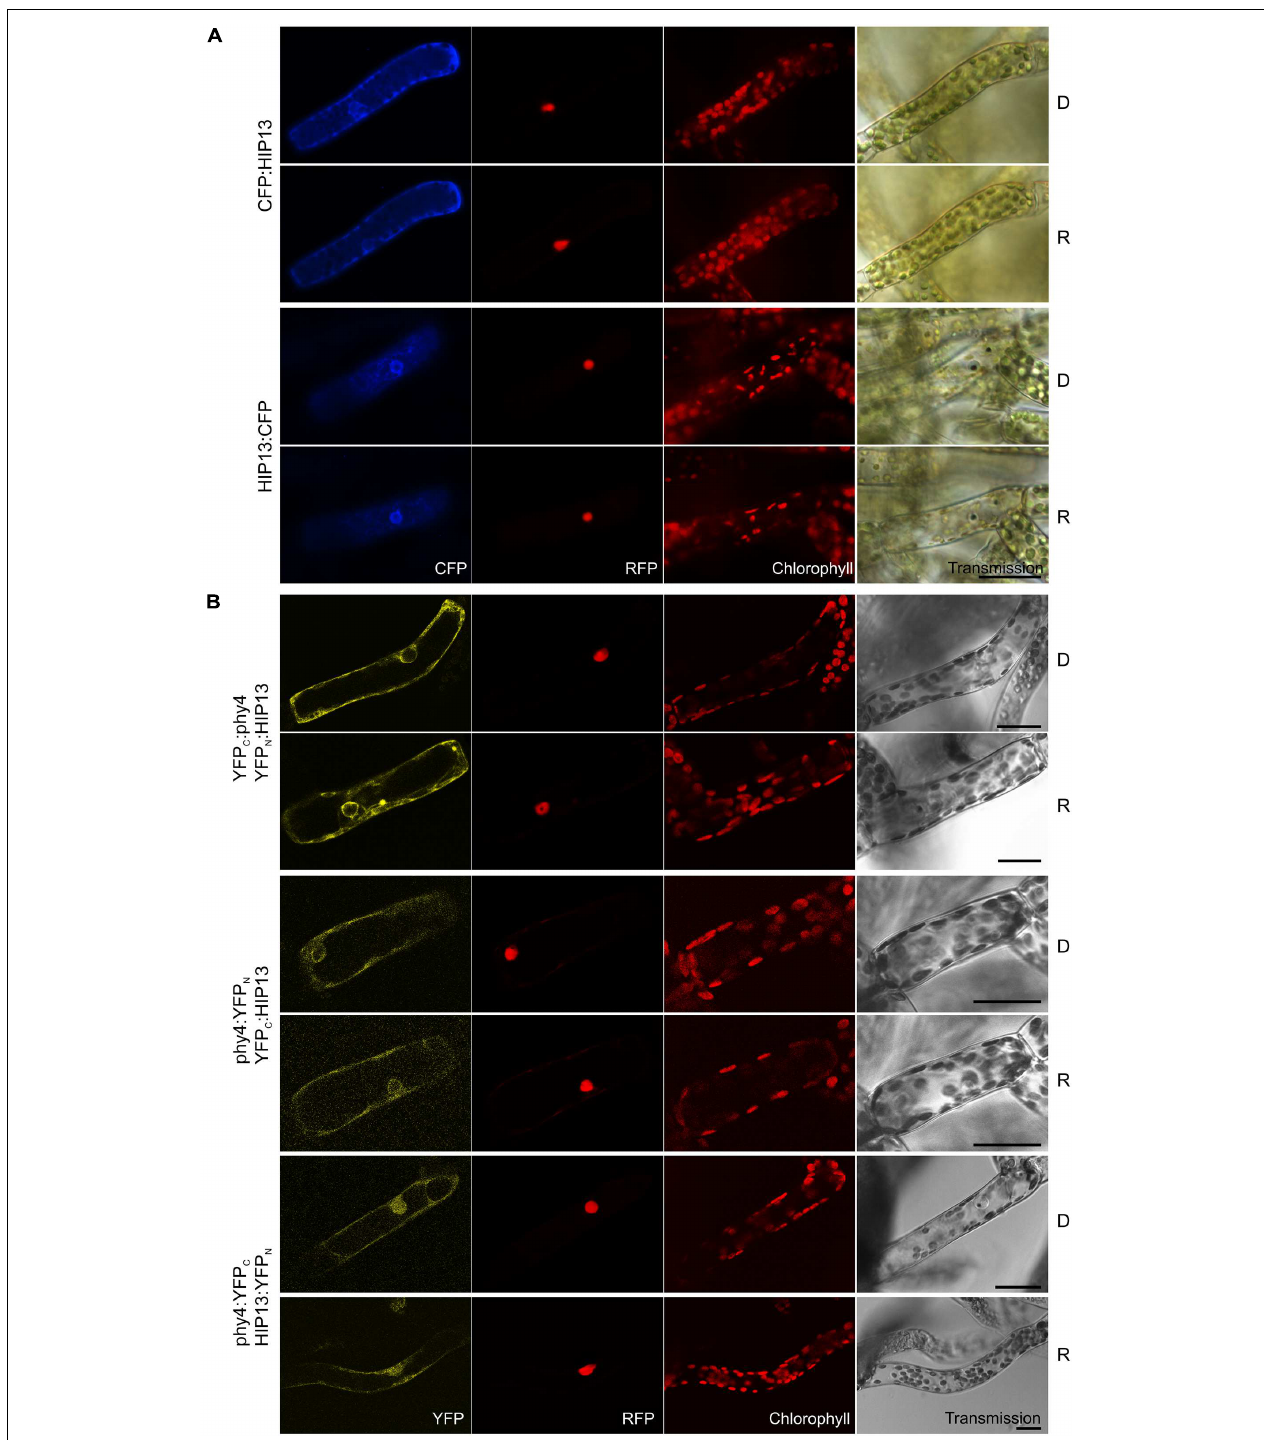
FIGURE 11 | HIP13 (Pp3c1_23670V1.1) intracellular localization (A) and split-YFP studies of HIP13–phy4 interaction (B) each without (D) and with R pre-treatment (R) using fluorescence- and confocal microscopy, respectively. Overall figure structure is analogous to Figure 1 . (A) Both CFP:HIP13 (rows 1 and 2) and HIP13:CFP (rows 3 and 4) were localized in the cytoplasm and perinuclear region (column 1, CFP). (B) All four split-YFP configurations were tested, however,